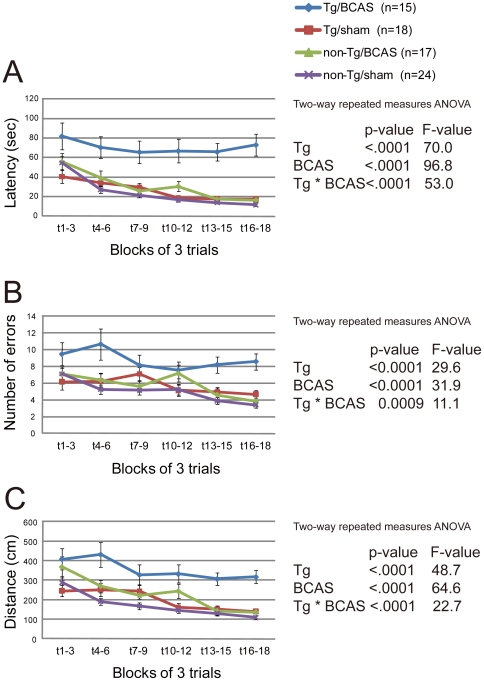
Interaction between APP overexpression and chronic cerebral hypoperfusion.Barnes maze test showed that APPSw/Ind-Tg/BCAS mice exhibited prolonged latency to reach the desired target (A), increased number of errors (B), and increased distance before reaching the desired target (C) compared to the other groups.